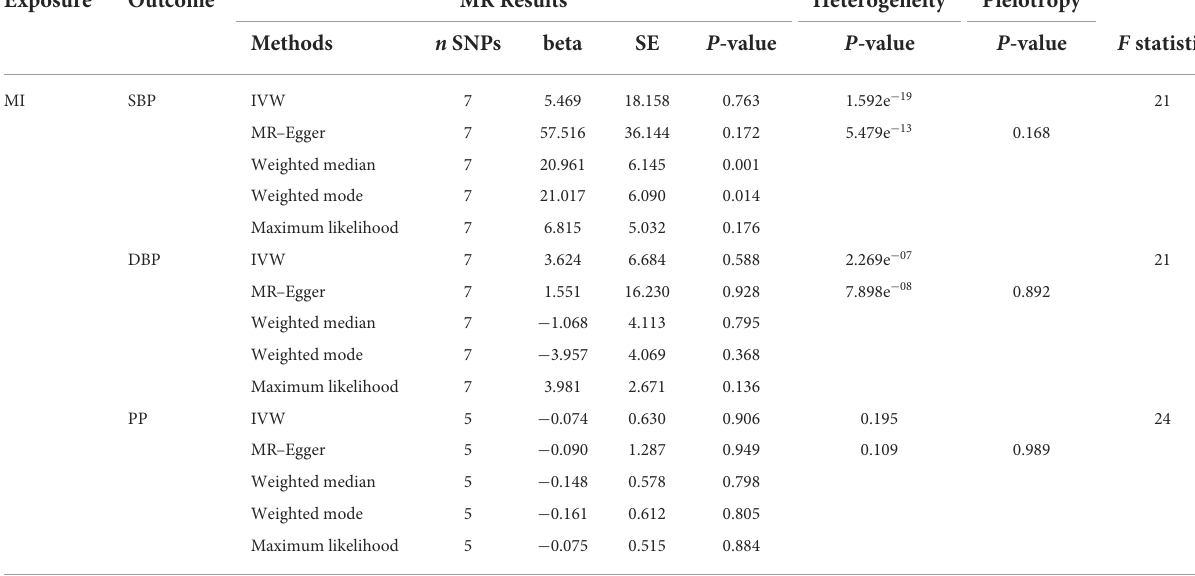
TABLE 2 Summary of reverse MR results of pressure and MI.